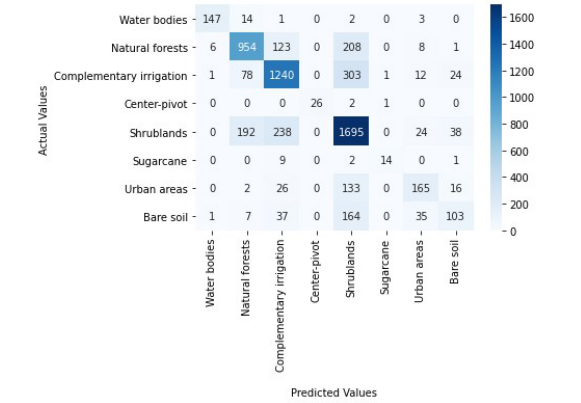
Figure 5 . Classification confusion matrix for the global